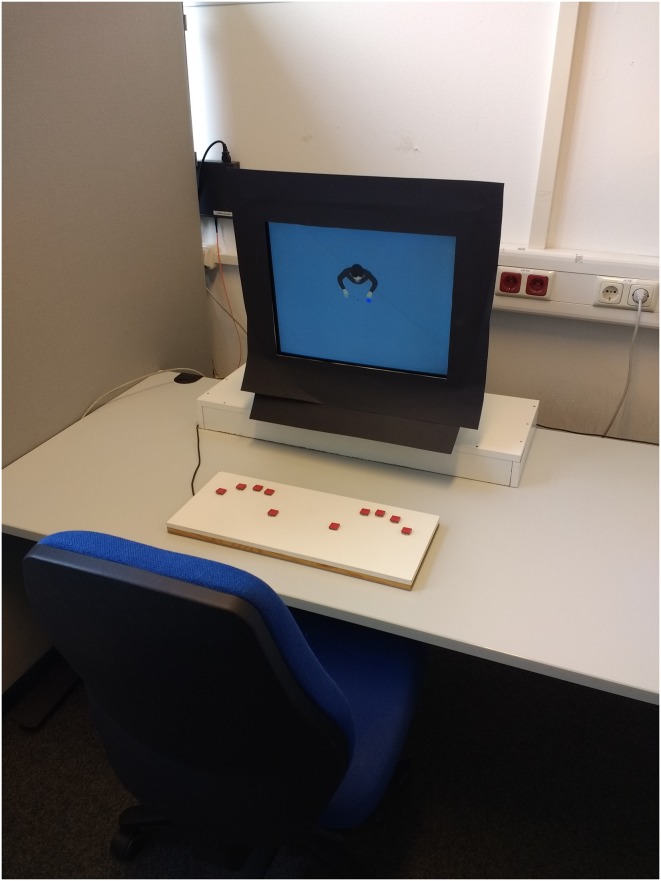
Experimental setup.